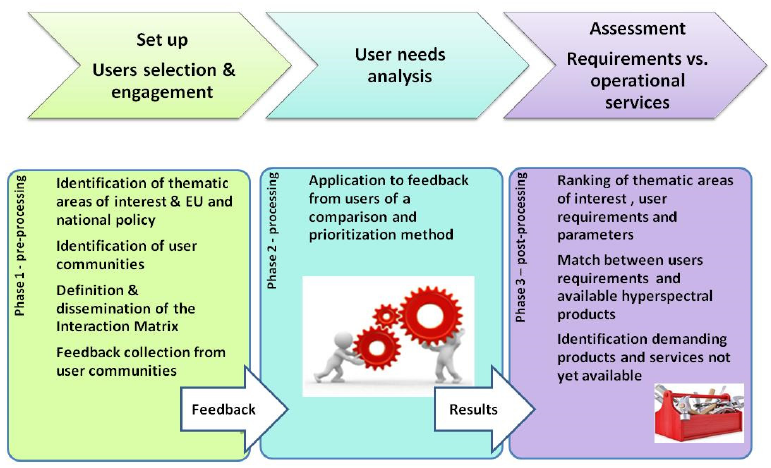
Figure 2. Interaction methodology developed for the study to collect and analyze user needs and to assess user requirements for hyperspectral products.